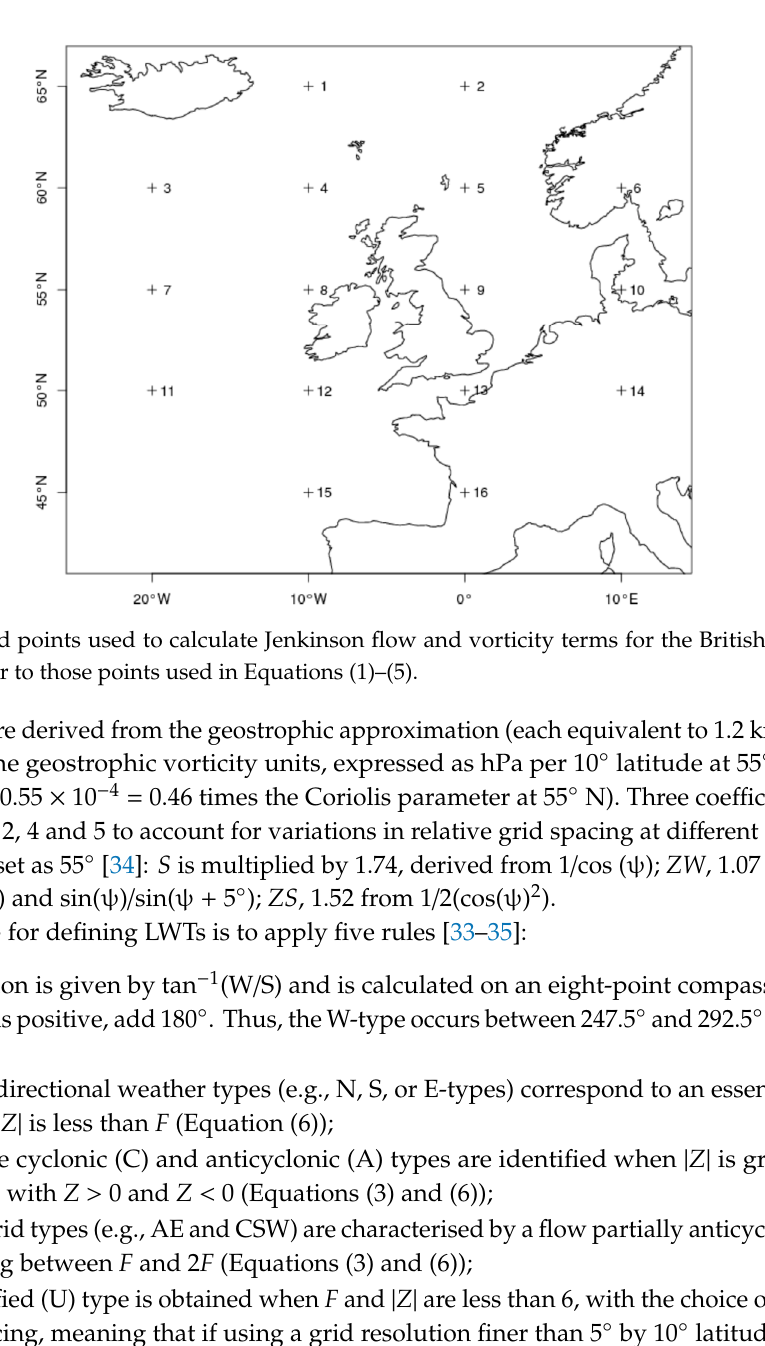
Table 1. Description of the seven main Lamb Weather Types (LWTs) and unclassified (U) type [33,75].